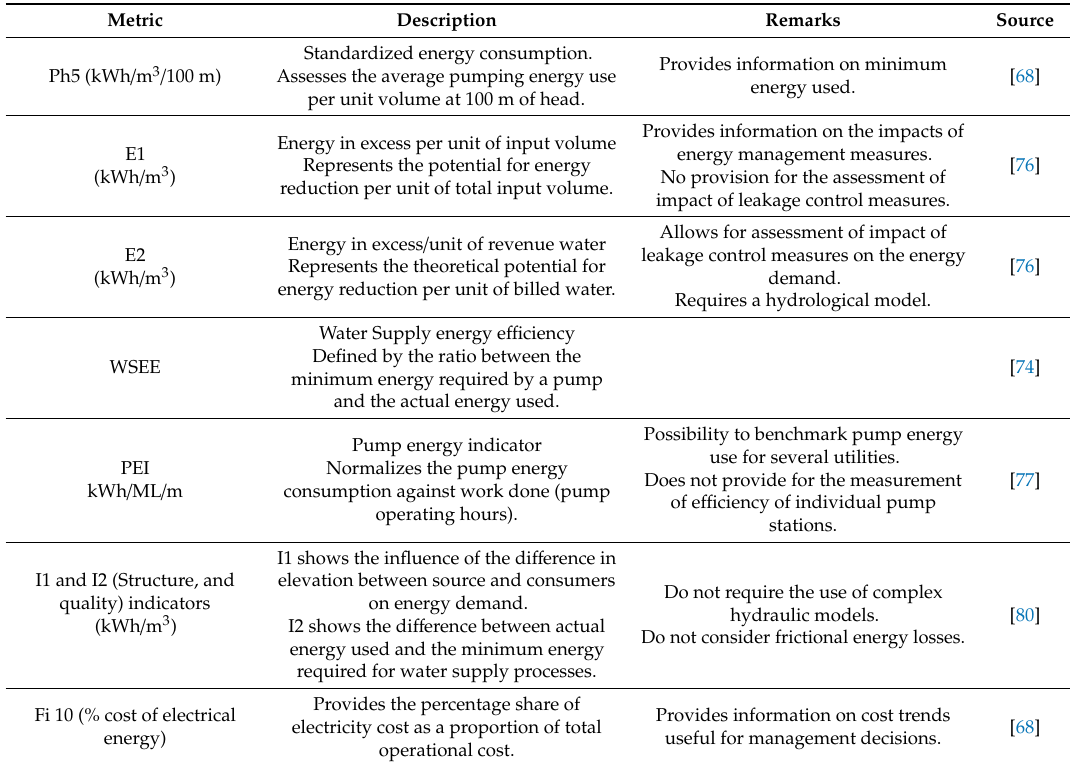
Table 3. Energy use metrics for energy use assessment for water services